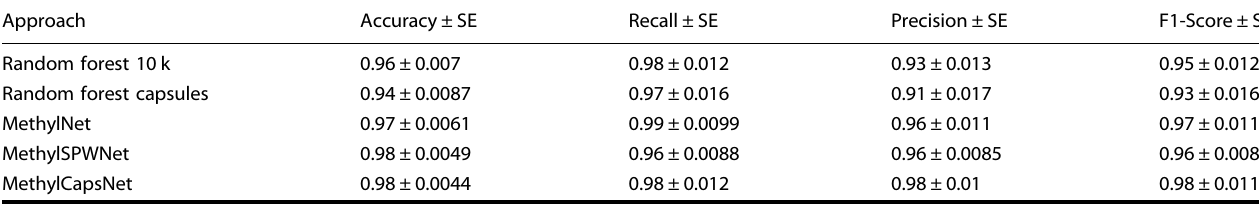
Table 1. Classi fi cation results for random forest approaches, MethylNet, MethylSPWNet, and MethylCapsNet a .